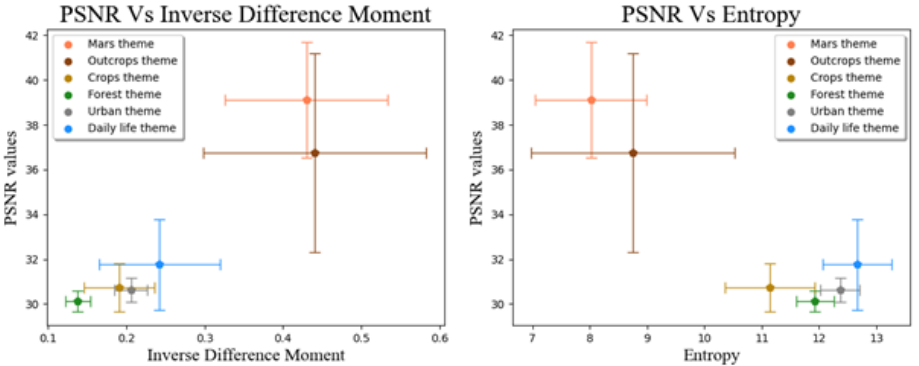
Figure 10. Mean PSNR values (error bars are SDs) plotted as a function of mean (± SD) texture index values for the inverse difference moment and entropy.